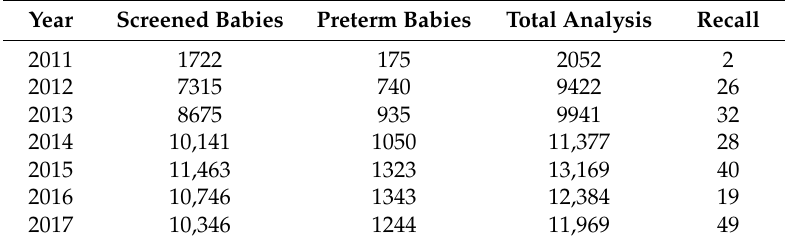
Table 1. The number of screened babies (as a sum of full-term and preterm babies), preterm babies, total analysis, and recall performed during the seven